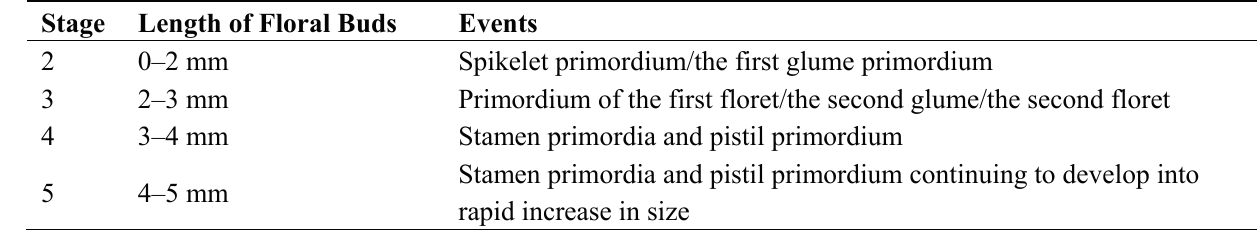
Table 1. Staging of the development of floral buds in D. latiflorus.